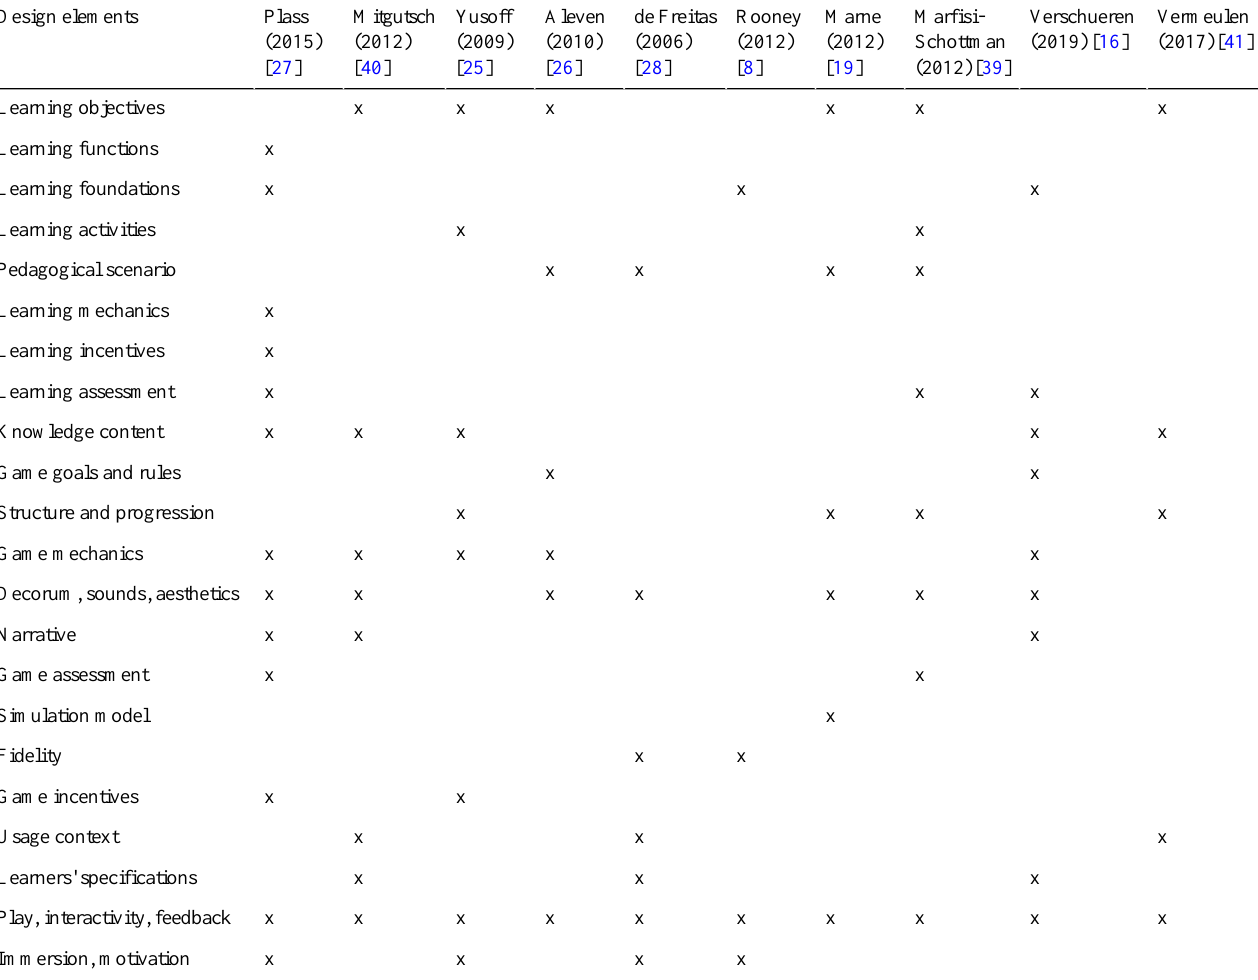
Table 1. Design elements extracted from existing serious game design frameworks and methodologies, which are presented in descending order of number of citations (from left to